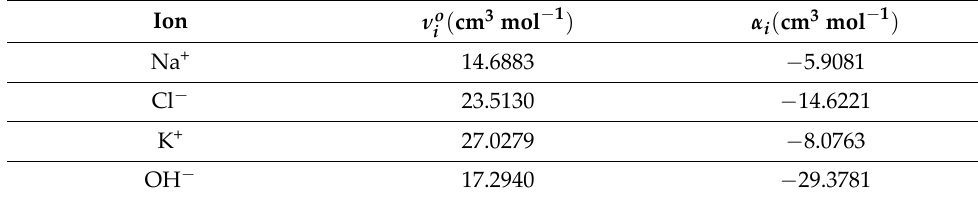
Table A4. Parameters for calculation of ionic densities at 298.15 K [72]. Table A13. Parameters for calculation of ionic densities at 298.15 K [72].